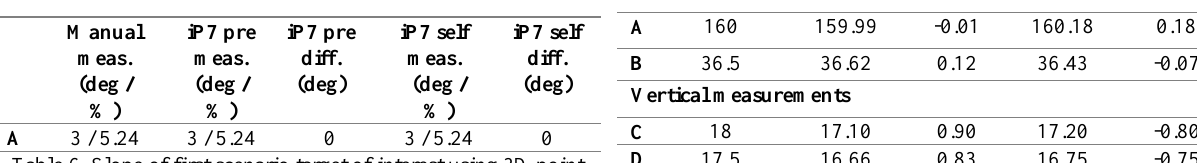
Table 6. Slope of first scenario target of interest using 3D point cloud generated with full set of images and without taking into account the camera calibration.